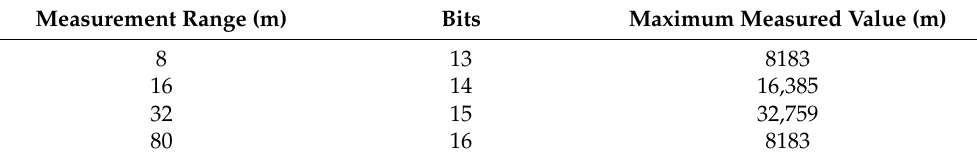
Table 2. Measurement